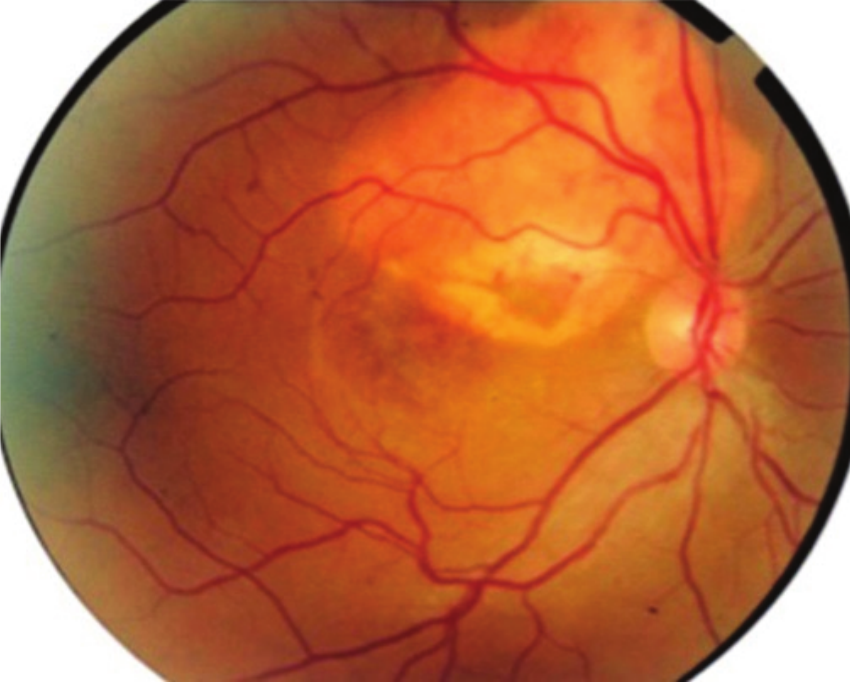
Figure 1. Color fundus photograph of the right